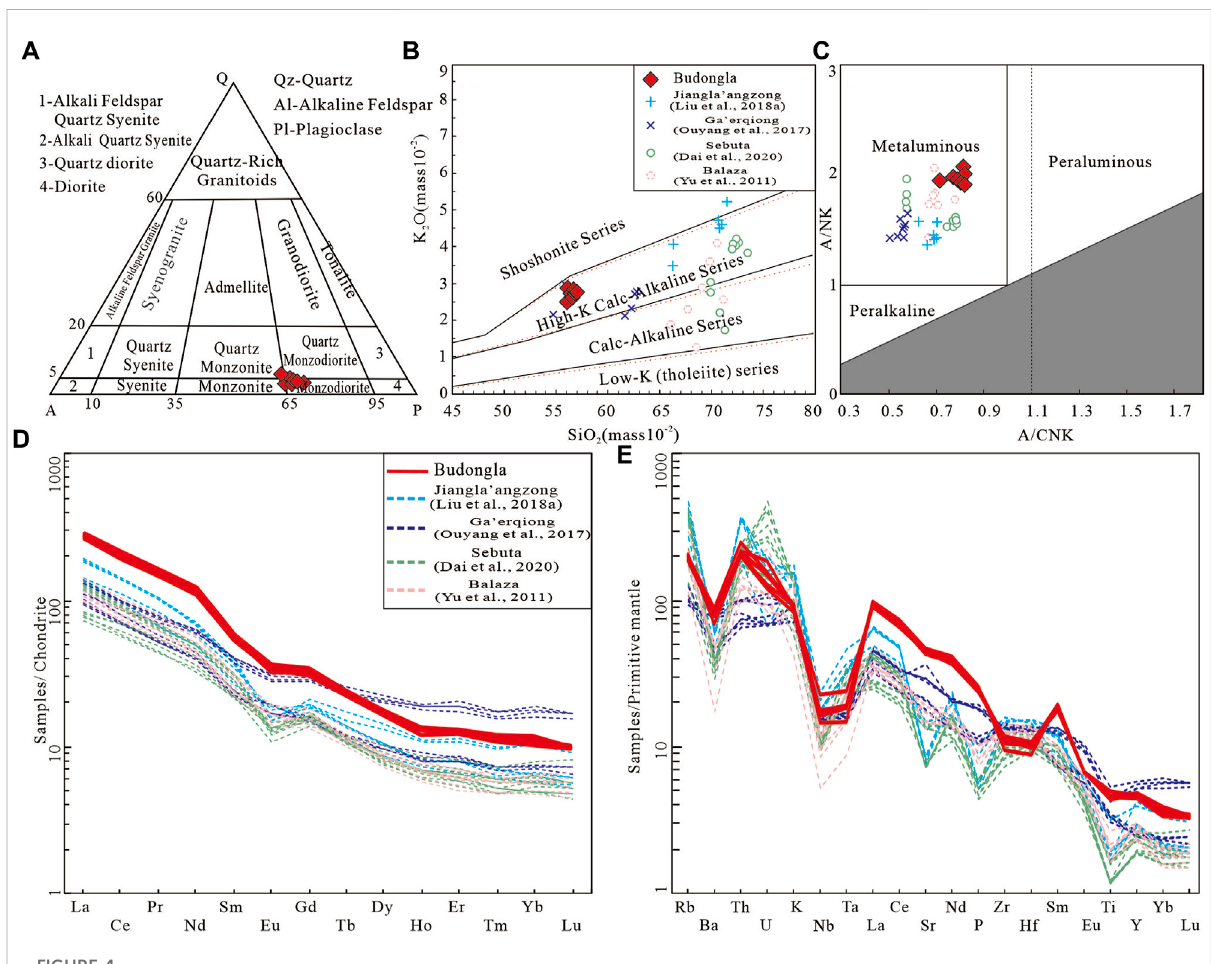
FIGURE 4 Geochemical diagrams of major elements. (A) , QAP Plots of rock (base map after LeMaitre, 2002); (B) , K 2 O vs. SiO 2 Plots (base map after Middlemost, 1994); (C) , A/NK vs. A/CNK Plots (base map after Maniar and Piccoli, 1989); (D) , Chondrite-normalised REE patterns (The normalizing values for REE are from Sun and McDonough and Sun, 1995); (E) , Mantle-normalised multi-element diagrams. (The normalizing values for REE and trace elements are from Sun and McDonough, 1989; McDonough and Sun,